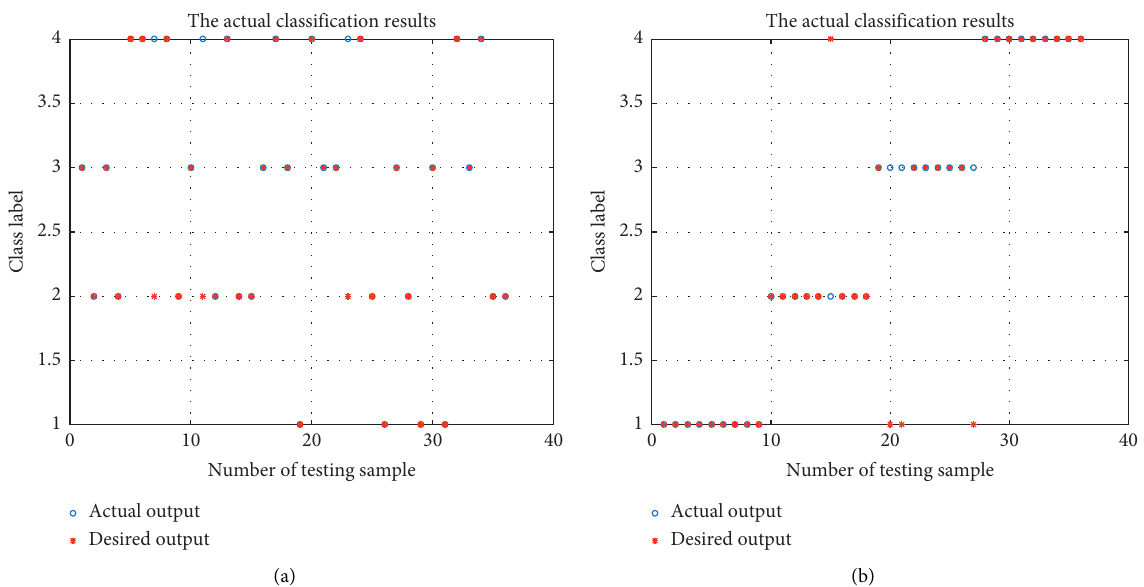
Figure 8: Identification of the numerical simulation based on the power spectrum entropy. (a) SVM model. (b) PSO-SVM